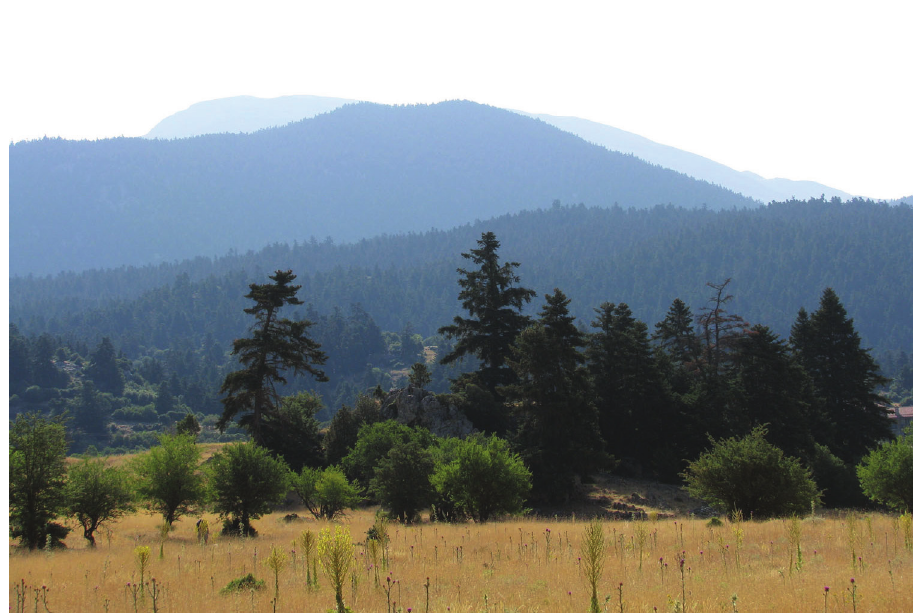
Figure 34. Habitat of P. timfristos . Central Greece, Mt. Parnassos, 19 July 2008. Photo by V.A.